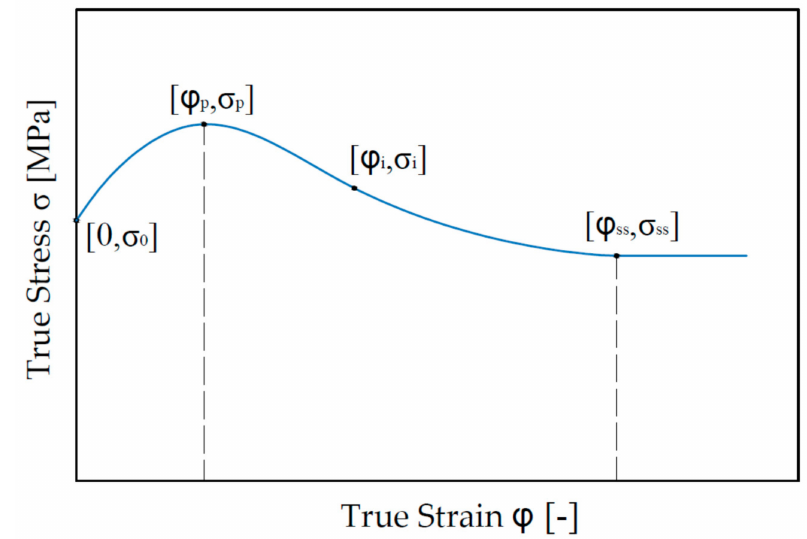
Figure 3. Typical True stress–True strain dependence of